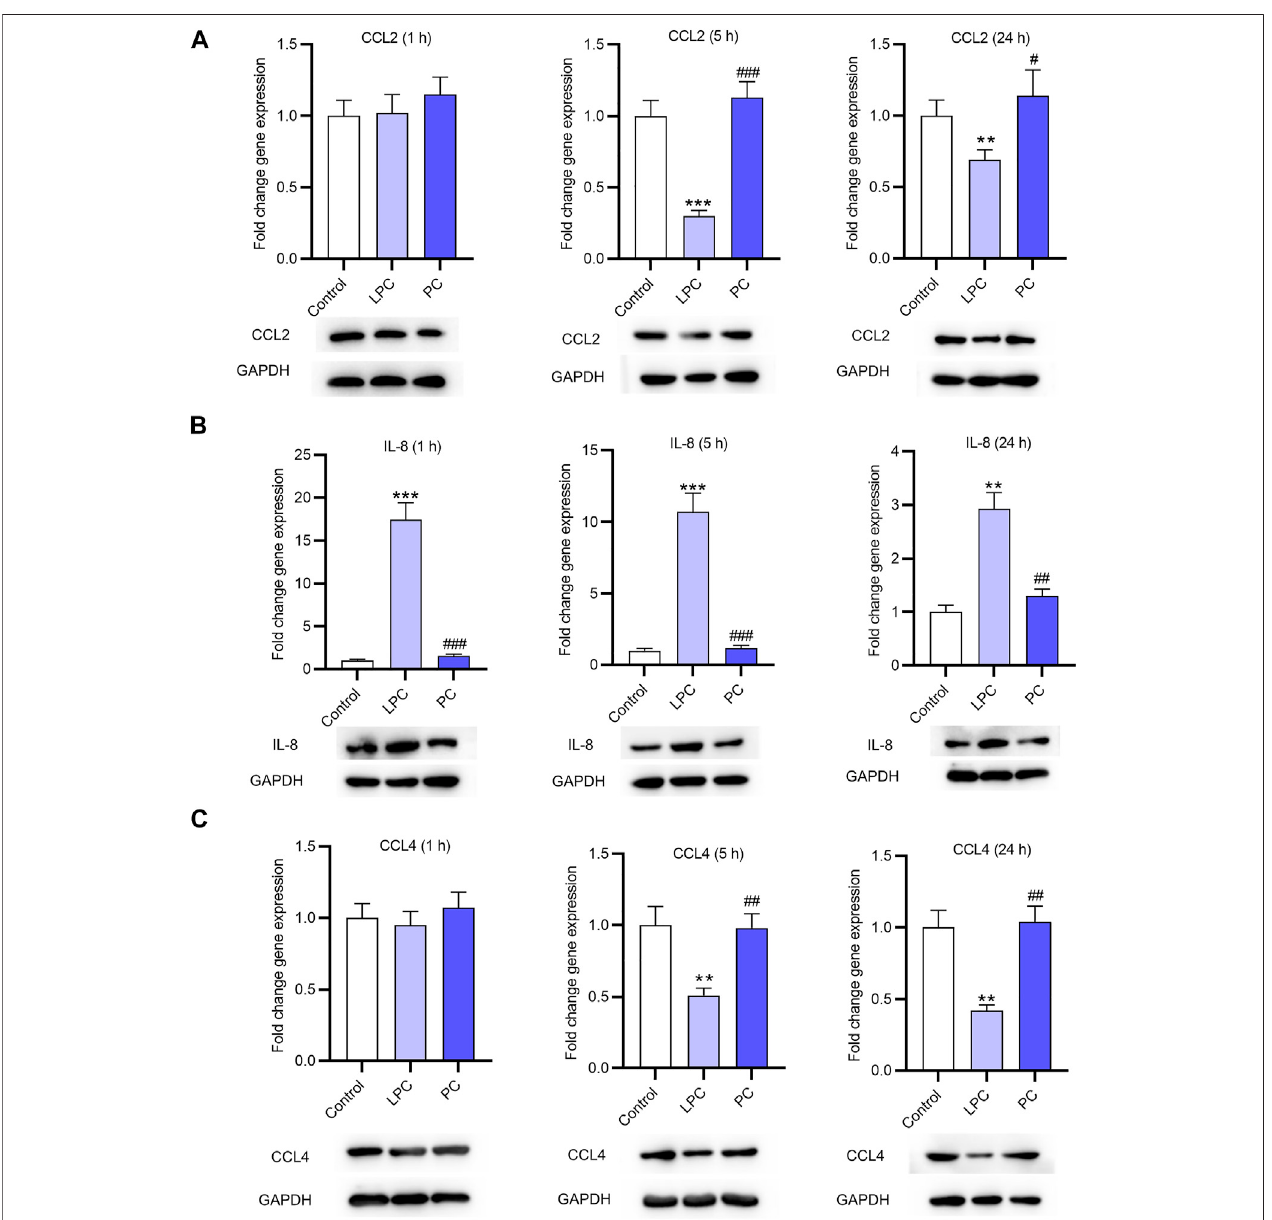
FIGURE 2 | The expression of in fl ammatory cytokines after LPC or PC treatment in EPCs. RT-qPCR and western blotting analyses were used to detect the expression of in fl ammatory factors including CCL2 (A) , IL-8 (B) , CCL4 (C) in EPCs after 10 μ g/ml of LPC or PC treatment for 1, 5 or 24 h ** p < 0.01, *** p < 0.001 compared with the control, # p < 0.05, ### p < 0.001 compared with the LPC